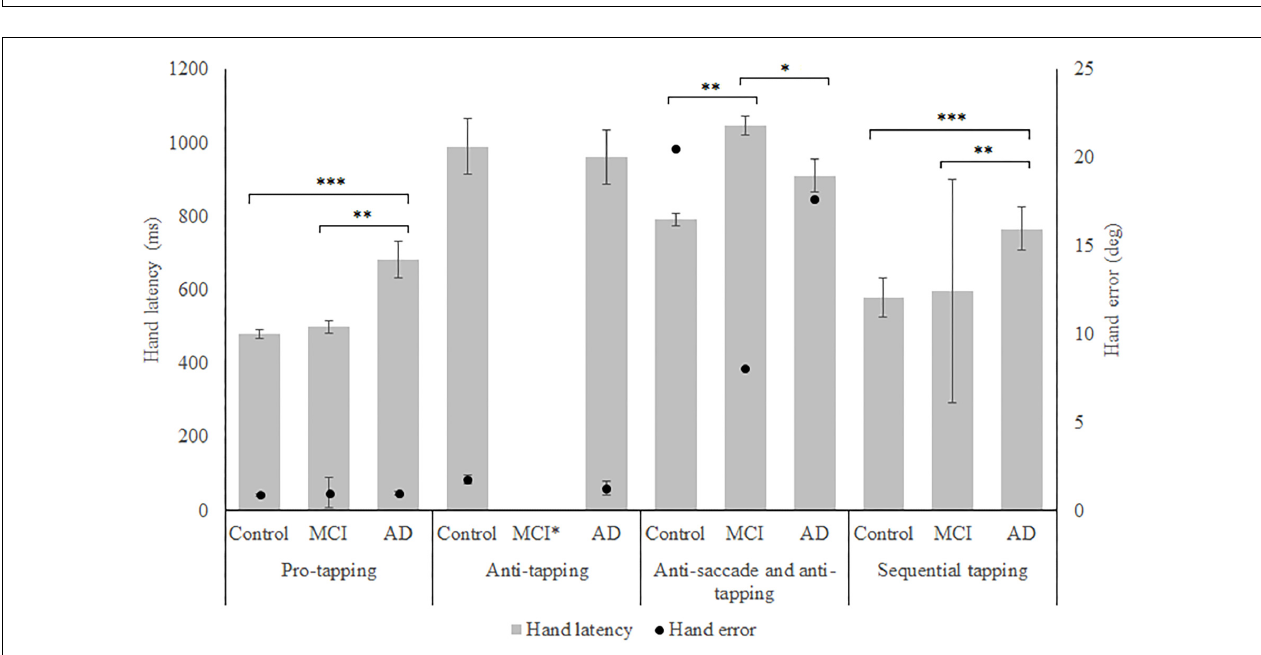
FIGURE 2 | Mean performance on eye latency for all groups, on all tasks. Error bars represent standard error. MCI*: MCI group was excluded because of insufficient data ( N = 3).